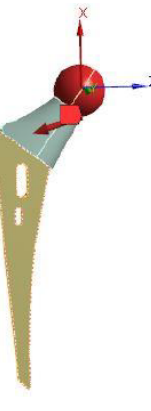
Figure 4: Fixed force